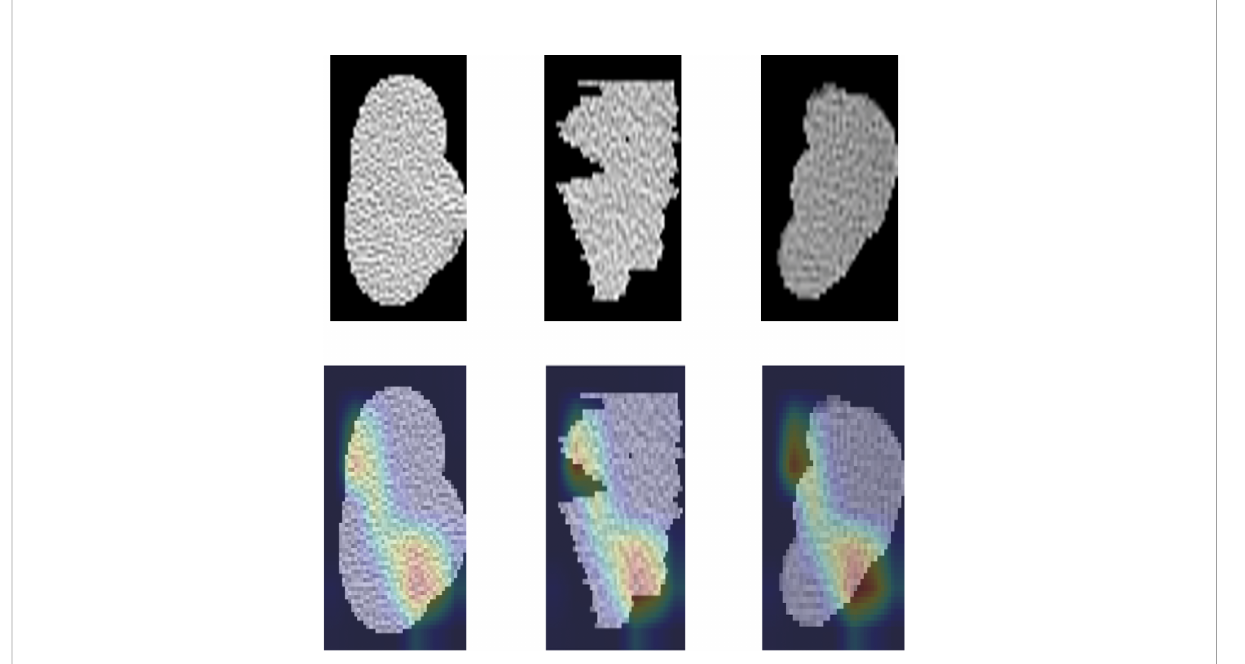
FIGURE 2 The heatmap of features generated from InceptionV3 for representative